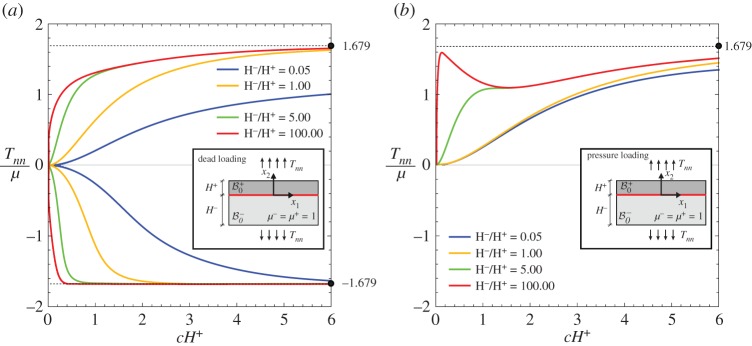
Bifurcation of two elastic incompressible layers in contact through a sliding interface. Both layers are modelled with the same neo-Hookean material and subject to the same prestress orthogonal to the interface. The normalized bifurcation stress Tnn/μ is reported versus the normalized wavenumber of the bifurcated field c1H+, for different values of the thickness ratio H−/H+. (Online version in colour.)